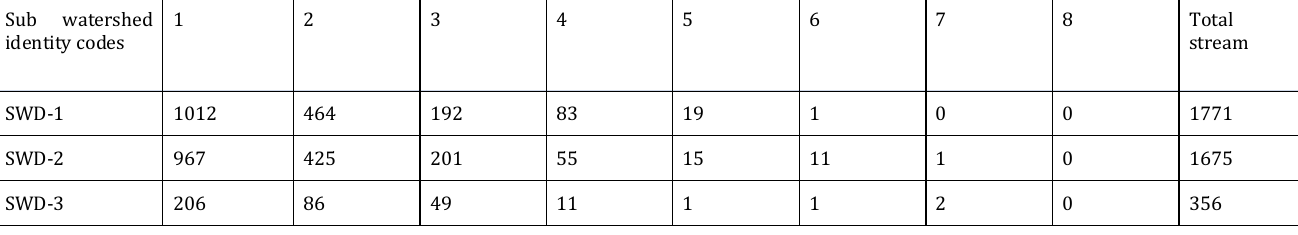
Table 7: Stream number in different order of upper watershed of river